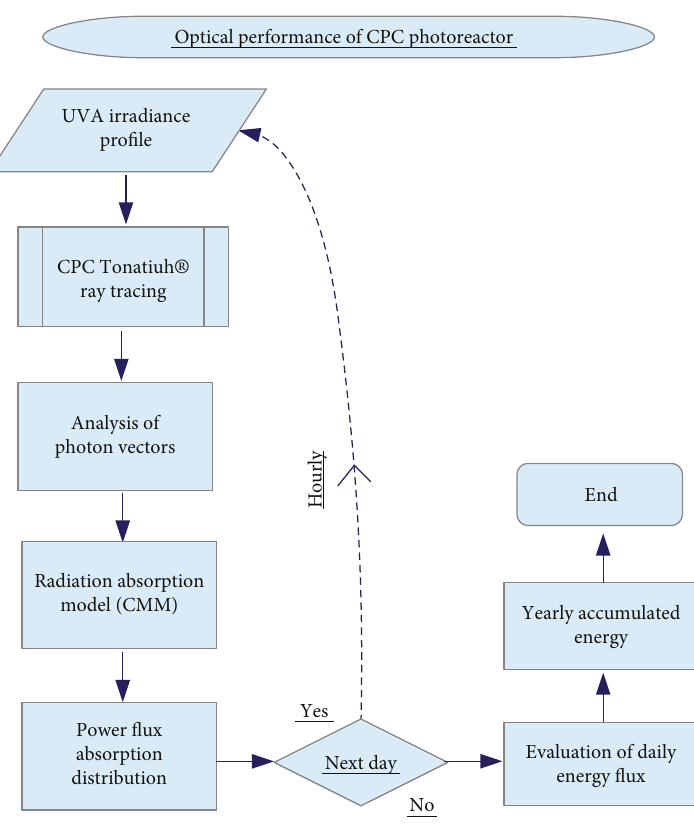
Figure 4: Flowchart: optical performance analysis for a CPC